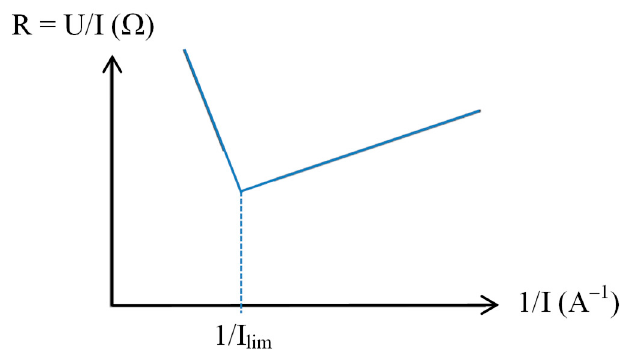
Figure 8. Determination of the reciprocal limiting current value by the method of Cowan and Brown